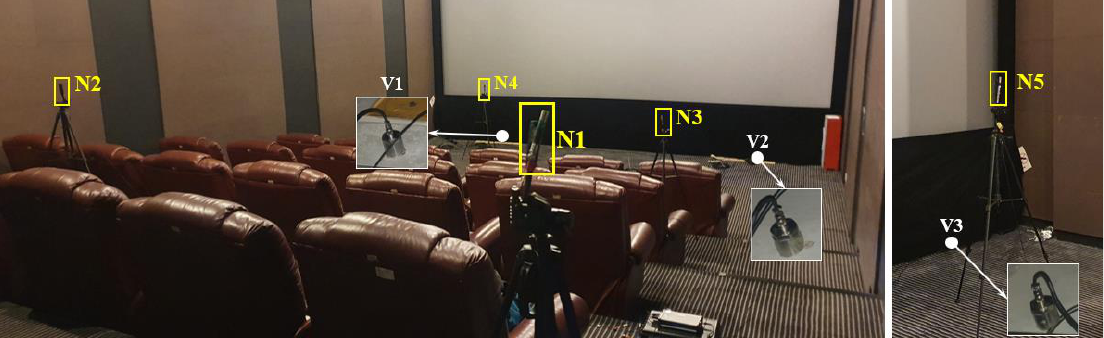
Figure 21. Setup of sound pressure test points in Hall A (left) and Hall B (right) in the cinema.